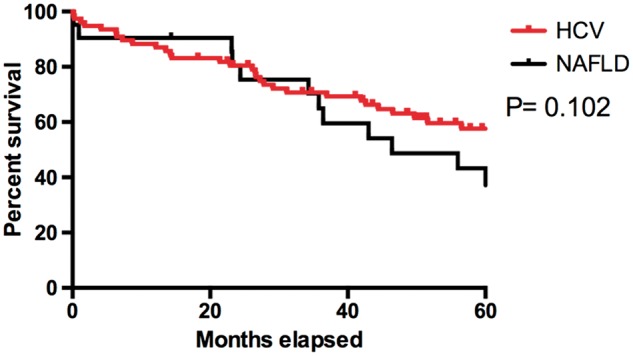
Kaplan-Meier curves for post-transplant survival of patients receiving transplants for HCC. HCV, Hepatitis C viral infection; NAFLD, non-alcoholic fatty liver disease.